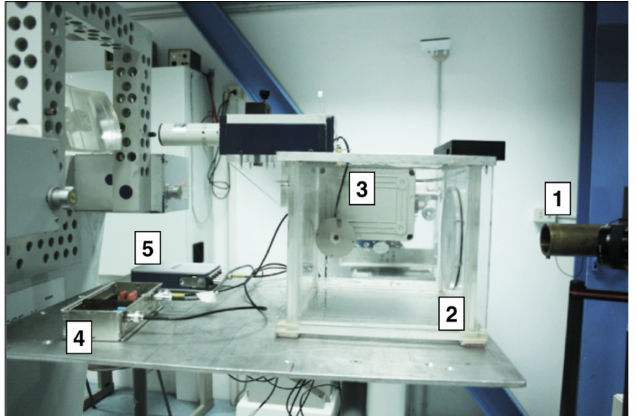
Figure 1. Experimental set-up adopted for the experimental measurements: (1) circular, 25 mm in diameter, brass collimator; (2) the water tank; (3) the electrode, positioned inside its holder and immersed in water outside the proton field; (4) the transimpedance amplifier; (5) the NI 9223 digital scope.